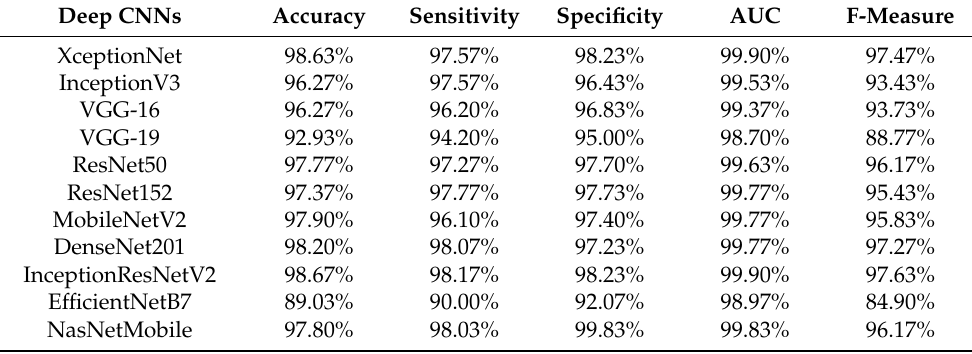
Table 8. Classification results of normal, pneumonia and COVID-19 using cropped lungs and 11 CNNs with Oversampling (Approach